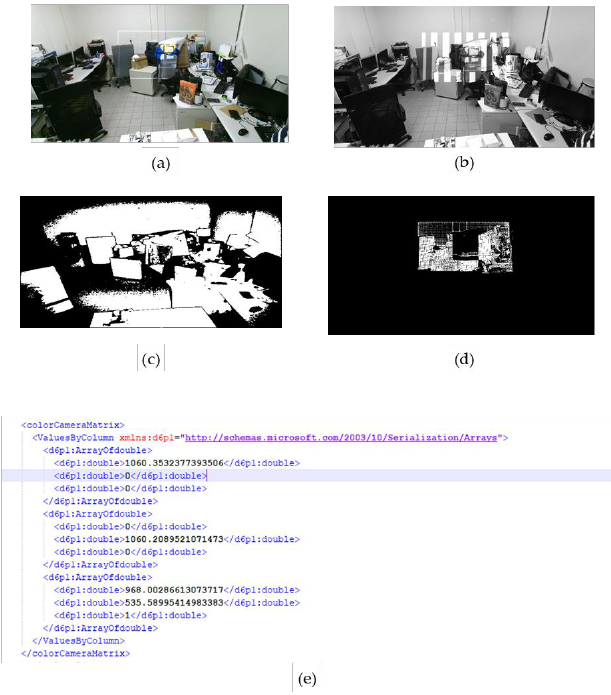
Figure 5. ( a ) Irregular Projection Surface. ( b ) Projected Gray Code Patterns on Irregular Surface ( c ) Camera Mask of Irregular Surface ( d ) Projector’s Valid Mask of Irregular Surface ( e ) Color Camera Matrix Excerpt.